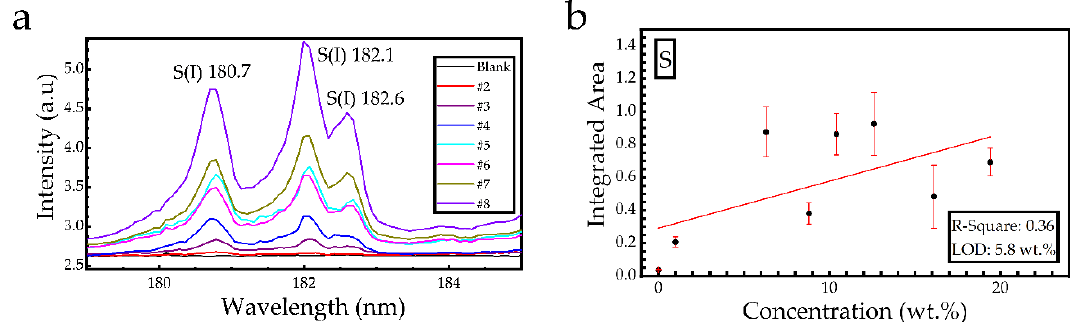
Figure 9. ( a ) LIBS spectra used for the calibration models. ( b ) Calibration curve obtained using linear regression.